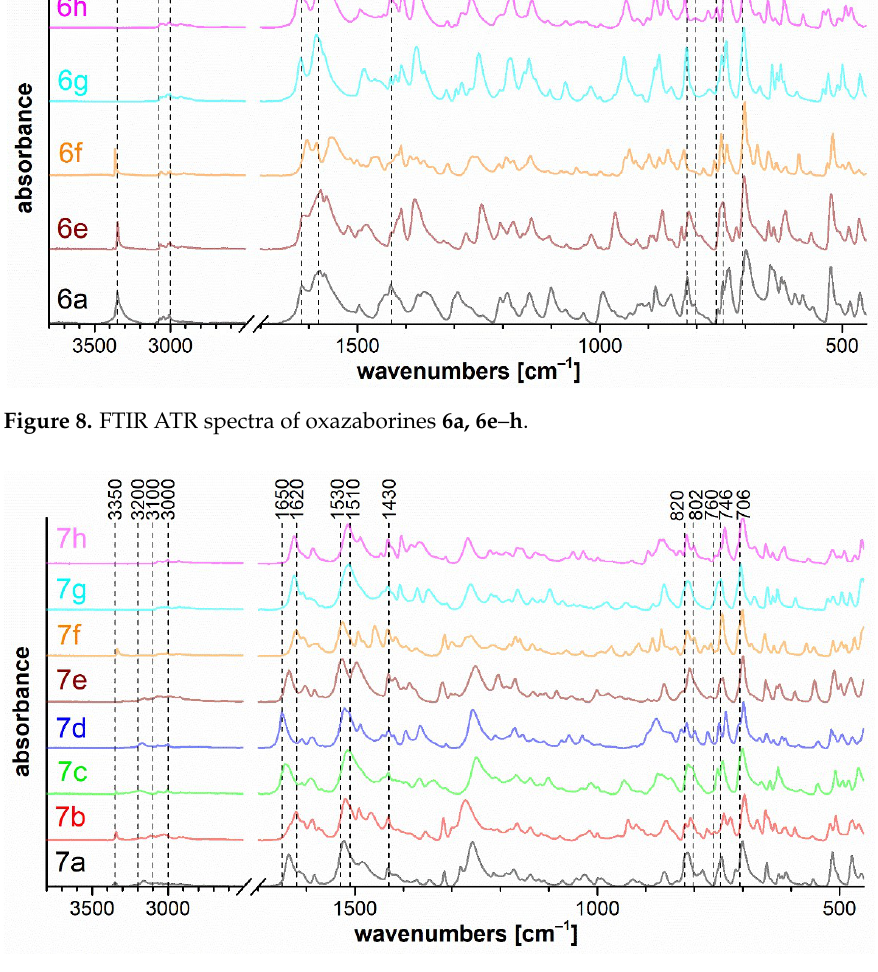
Figure 9. FTIR ATR spectra of diazaborinones 7a – h .